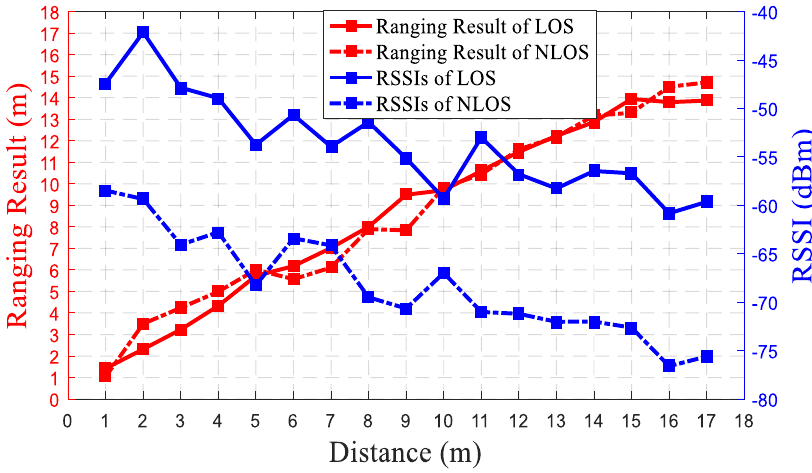
Figure 3. Ranging results and the received signal strength indicators (RSSIs) of line-of-sight (LOS/NLOS) signals.